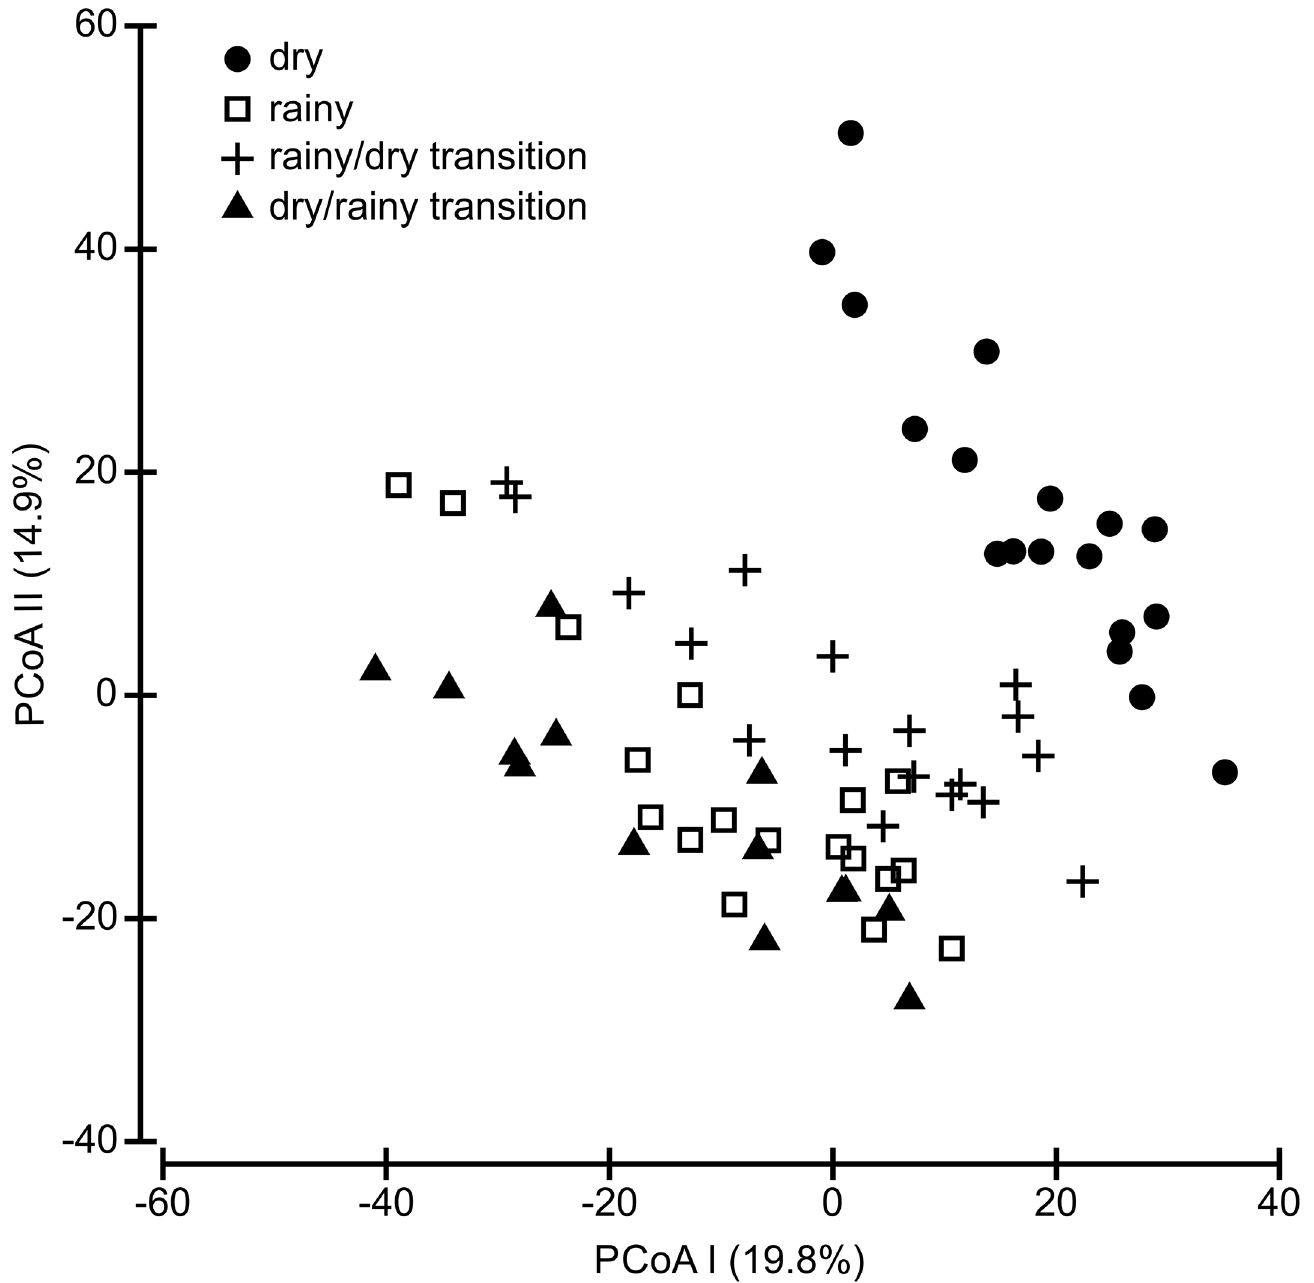
Fig 3. Principal Coordinates Analysis (PCoA) ordination of species composition of bird species among hydrocycles, using the Bray-Curtis distance matrix of transformedabundance data. Dry season are representedby circles, Rainy by squares, Rainy/dry transition by plus and Dry/ rainy transition by triangles. Numbersin parentheses are the percentageof varianceexplainedby each